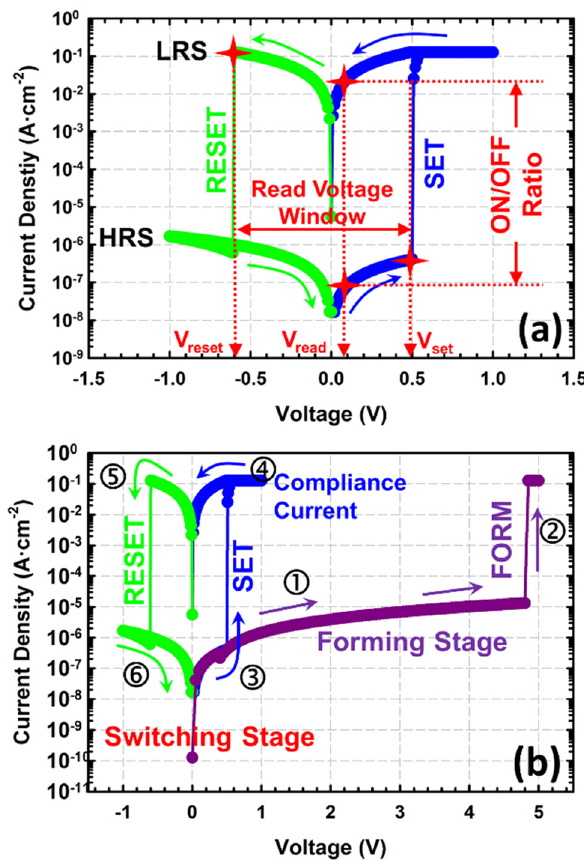
Figure 2: ( a ) Typical current density and voltage plot of a resistive switching RAM with high - and low - resistive states, labeled as HRS and LRS, respectively. Set, reset, and read voltages are represented by V set , V reset , and V read , respectively. Arrows indicate the sweeping direction. ( b ) Form voltage applied during the forming stage of a typical resistive switching RAM before the switching cycle is per - formed. Numbers beside arrows show the sequence of sweeping. Compliance current ( I cc ) of 1 × 10 − 1 A/cm 2 is set during the forming stage and switching stage during the set cycle only and I cc is released during the reset